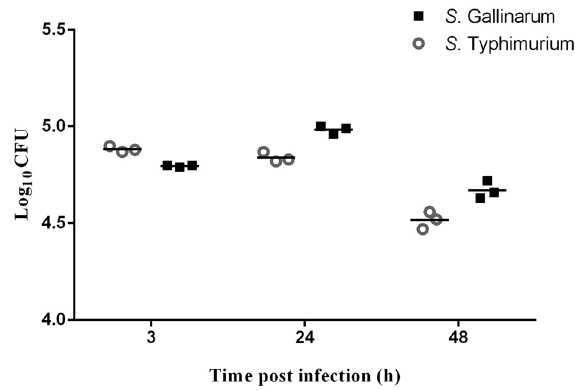
Figure 3. Intracellular survival of S . Gallinarum and S . Typhimurium in chicken dendritic cells (chMoDCs). The chMoDCs were treated with S . Gallinarum and S . Typhimurium for 90 min with a multiplicity of infection of 10:1 and viable bacterial counting was done on HEA plate following lysis of cells at 3, 24 and 48 h post- infection. Individual data point represents an independent experiment with the horizontal bars showing the corresponding arithmetic